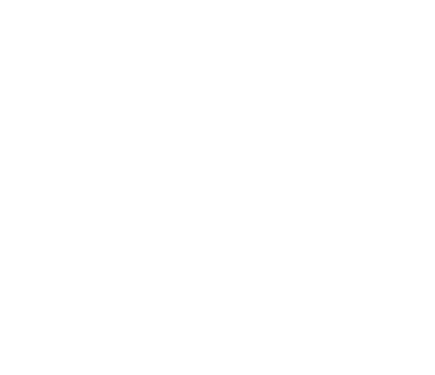
Figure 4. Distribution of miRNAs for asthma severity-risk among four tissues (BAL, BEC, sputum, and blood).